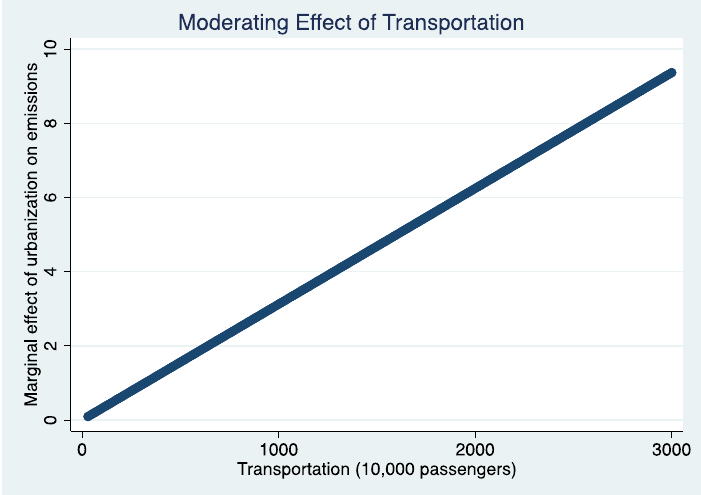
Figure 10. Moderating effect of infrastructure.